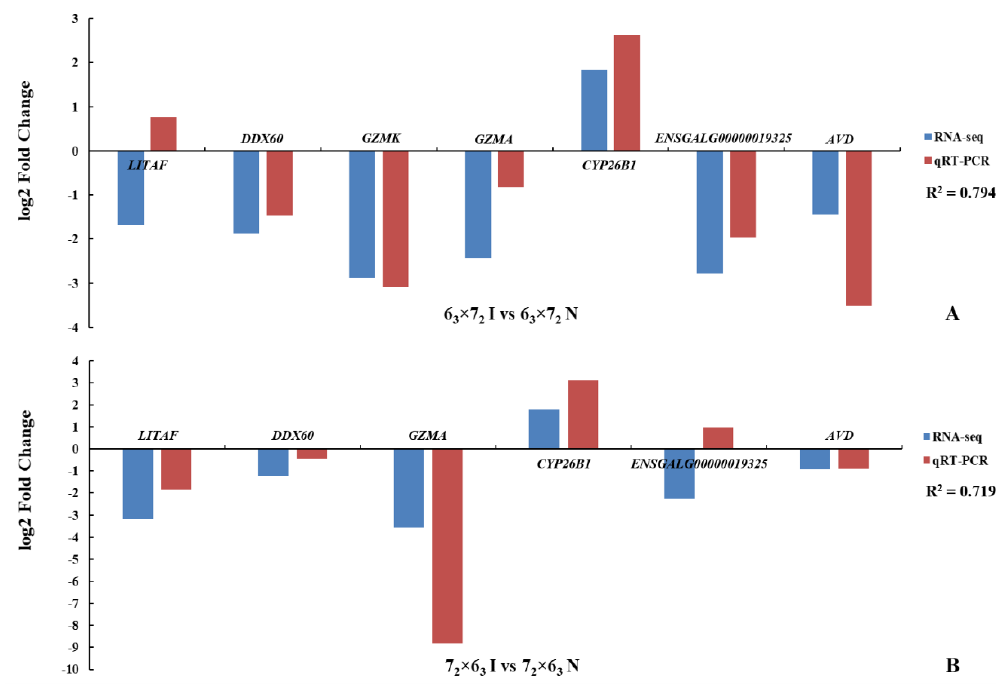
Figure 5. The qRT-PCR of seven genes for validating the RNA-seq results in intercrosses ( A ) 6 3 × 7 2 308